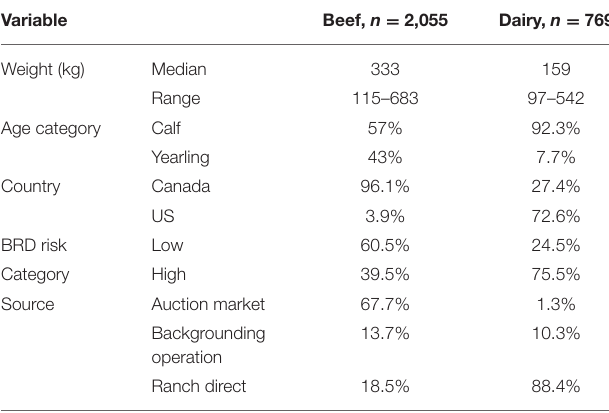
TABLE 3 | Feedlot cattle demographics from beef and dairy-type cattle upon feedlot arrival.